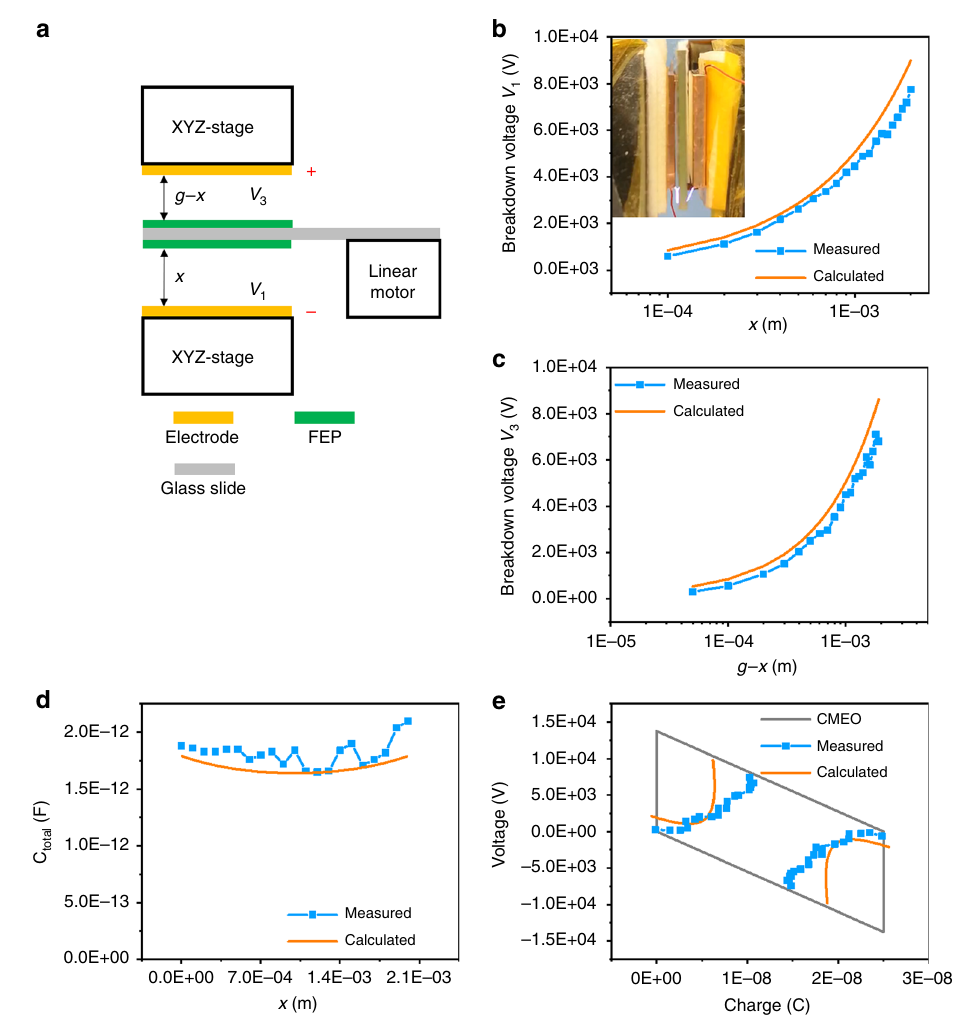
Fig. 4 Breakdown for contact freestanding-triboelectric-layer nanogenerator. a Schematic diagram of CFT mode TENG. Average breakdown voltage b V 1 and c V 3 from experiment, compared with theoretical values calculated by Paschen ’ s law. Figure of visible spark insets in b . d Average capacitance C total , compared with theoretical values calculated by the equation considering two-side edge effects. e Cycle for maximized energy output with the threshold breakdown curve compared with theoretical curve by Paschen ’ s law. Q SC,max = 25 nC. Source data are provided as a Source Data fi le Table 3 Experimental parameters of the CFT mode TENG as the TENG1